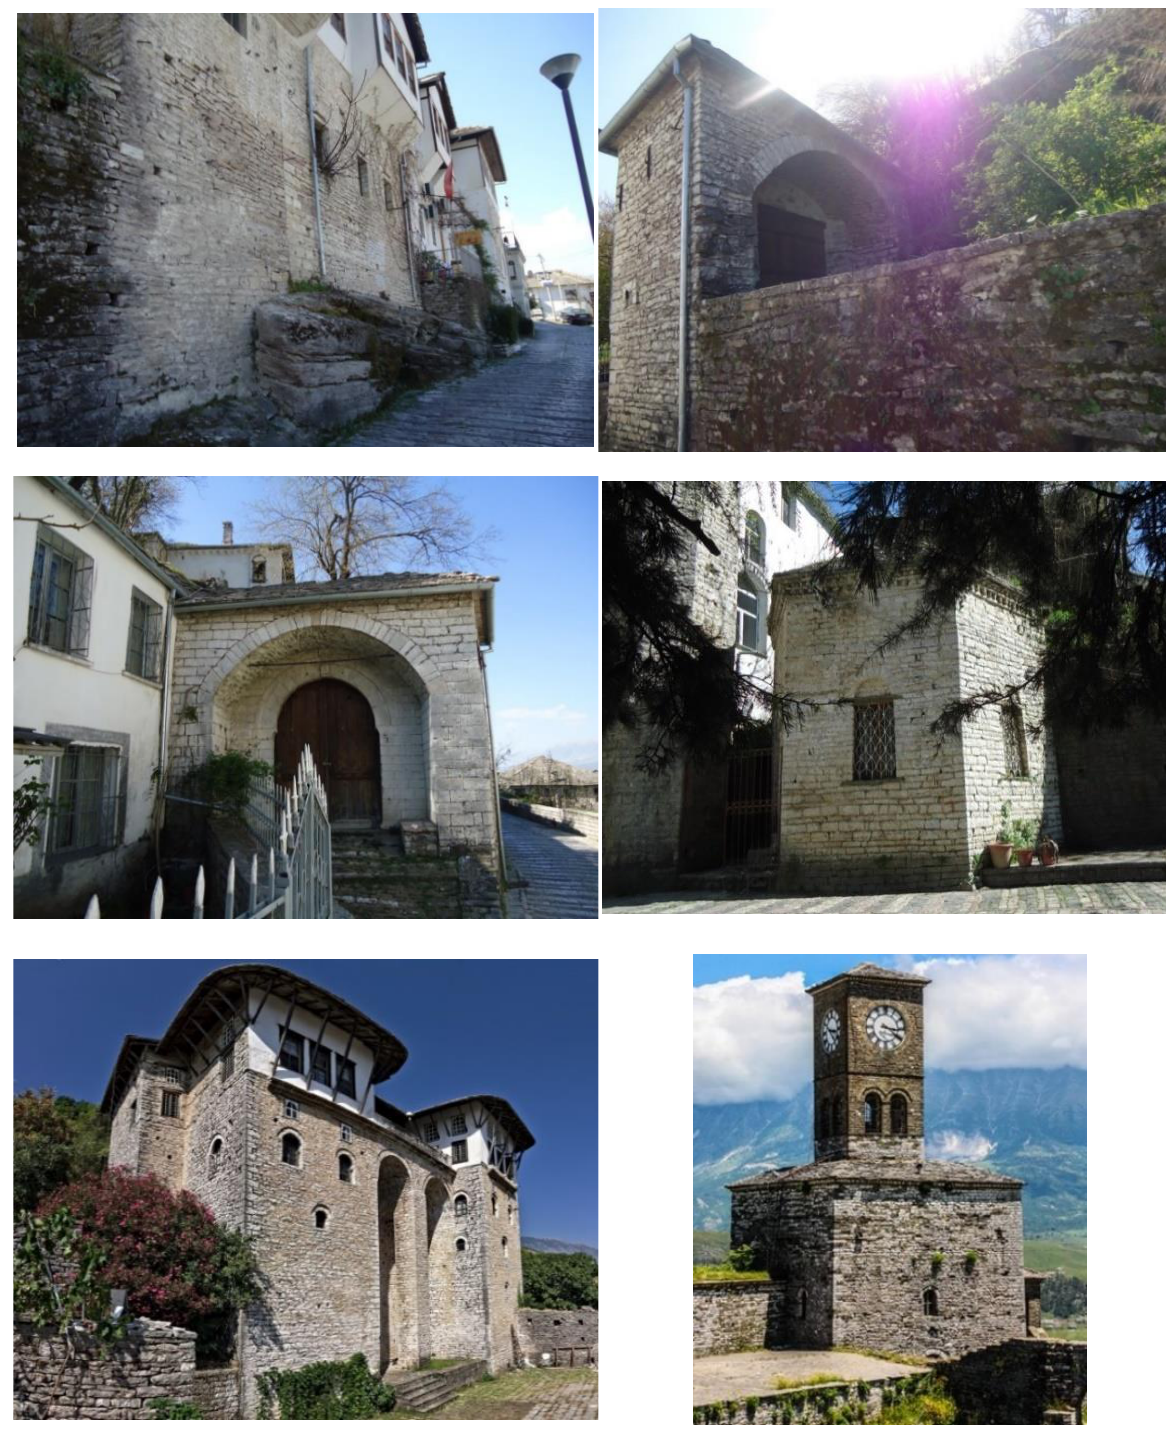
Figure 13. Several typical stone masonry buildings of Gjirokastër. The analysis of each parameter leads to a numerical value (for a total of 7 numerical results) based on its fulfillment category. The combination of the seven numerical values gives the value of MQI [40]. This is based on a wall panel and it is aimed at verifying if a wall complies with the “rules of the art” for the Gjirokastër historic walls (Figure 15). Based on this analysis, it is possible to calculate three numerical values. Because the structural response of a wall also depends on the loading condition, the values assigned to the